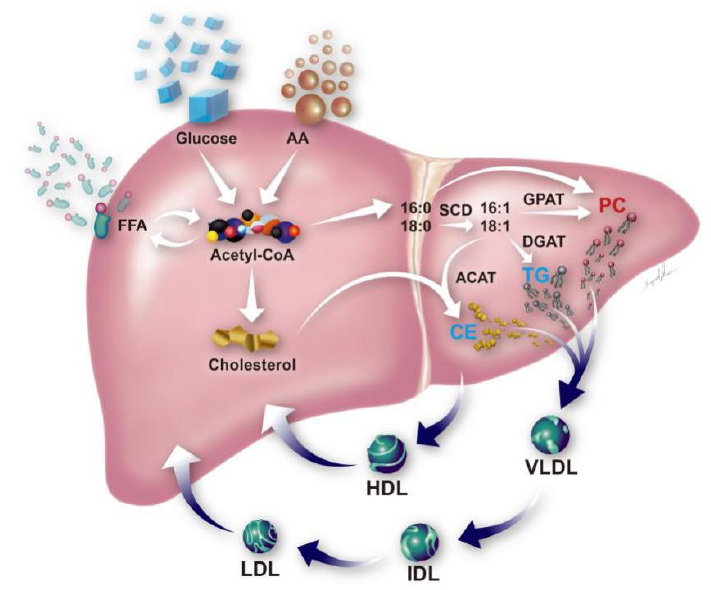
Figure 6. Schematic illustration of metabolic disturbances associated with poor outcomes of liver transplants.Metabolites that increased in the plasma level in early allograft dysfunction are labeled in red (i.e., PC) whereas those that decreased in level are labeled in light blue (i.e., TG and CE). The enzymes involved in the de novo synthesis of TG, PC and CE, including stearoyl-CoA desaturase (SCD), acyl-CoA:cholesterol acyltransferase (ACAT), diacylglycerol acyltransferase (DGAT), and microsomal glycerol phosphate acyltransferase (GPAT), are located in the endoplasmic reticulum membrane. PC, phosphatidylcholine; CE, cholesteryl ester; TG, triacylglycerol. HDL, high density lipoprotein; LDL, low density lipoprotein; VLDL, very low density lipoprotein; IDL, intermediate density lipoprotein; AA, amino acid; FFA, free fatty acid.